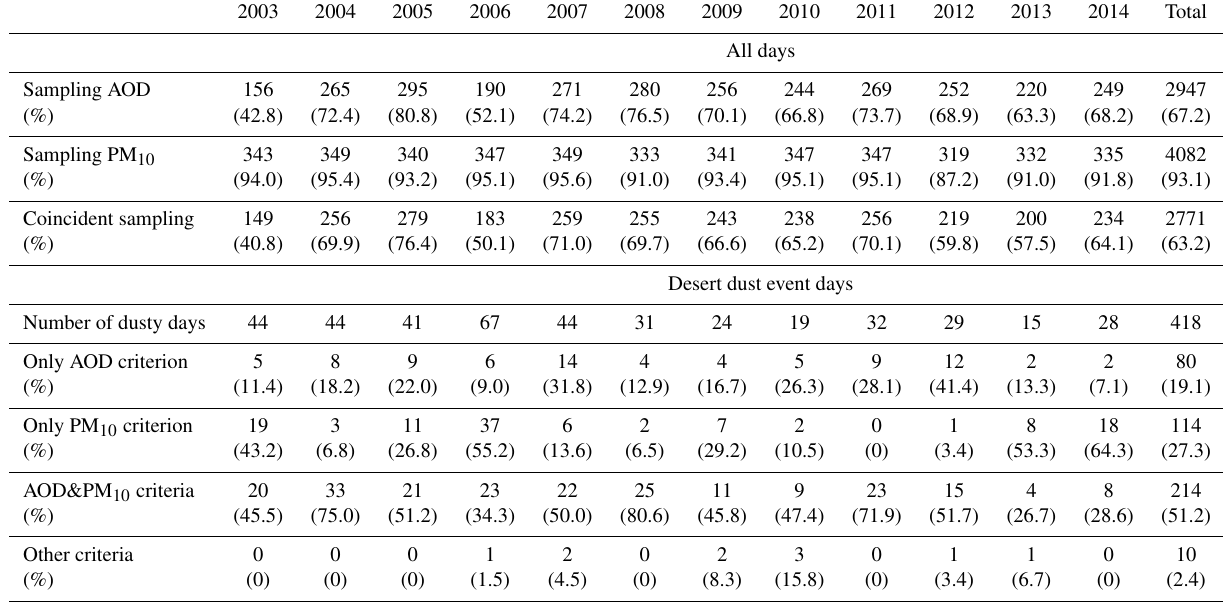
Table 1. Annual sum of days with aerosol data of AERONET and EMEP databases (“all days”) used in this study. Yearly number of dusty days in the DD inventory (“desert dust event days”) identified by criteria of AOD, PM 10 , AOD, and PM 10 and other ancillary information. The relative coverage (percentage) is also given in parenthesis. See Sect. 3 for further details about the criteria